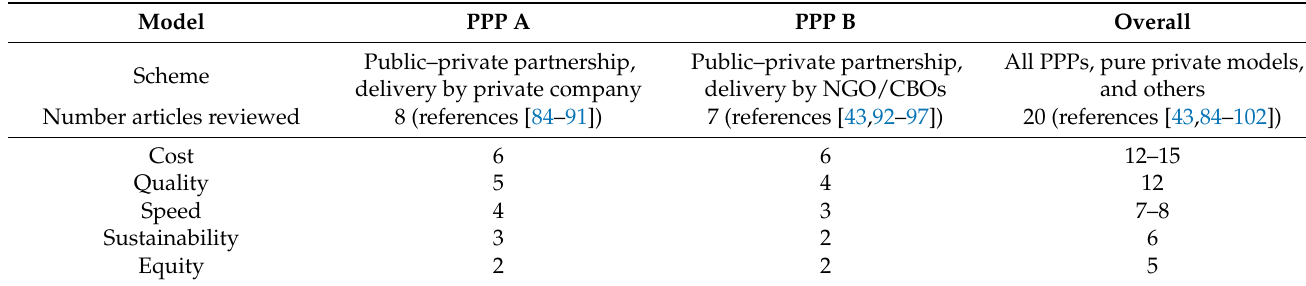
Table 3. Relevance of political economy realization indicators for access.